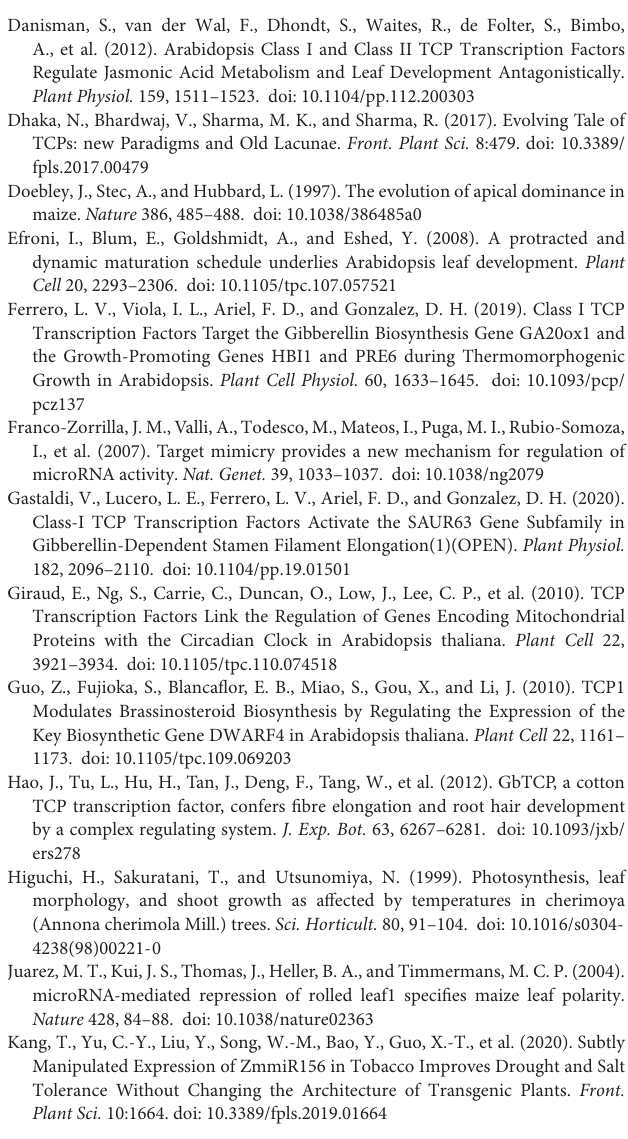
Supplementary Figure 1 | The expression of IbmiR319 (A) and its target genes IbTCP11, 17 (B) in MIM319. Supplementary Figure 2 | The length of leaf in